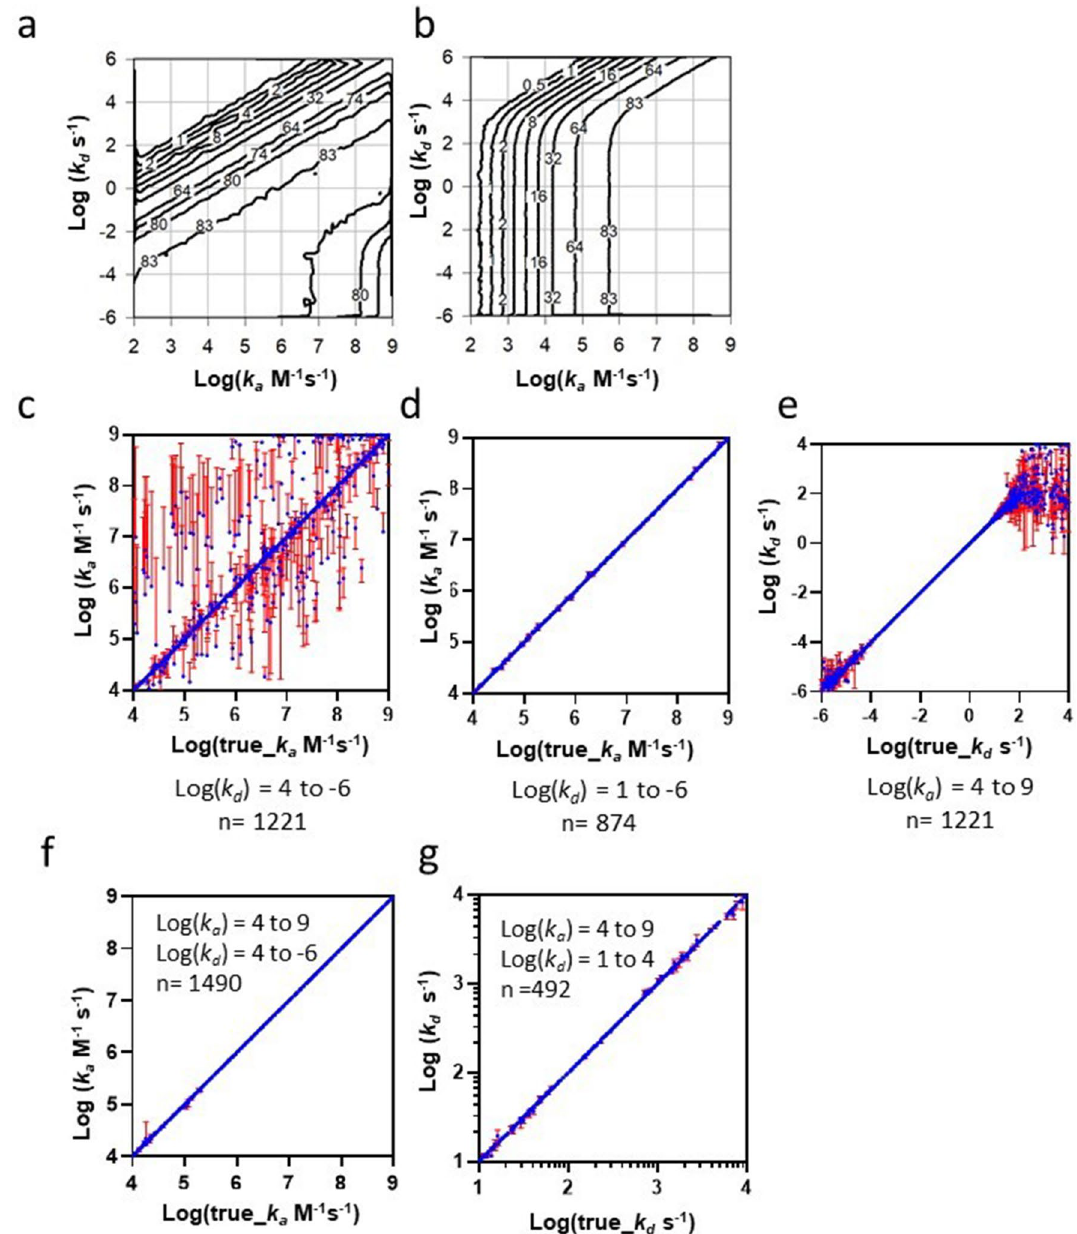
Figure 6. Comparison of the competitive kinetics assay with the rebinding assay in terms of sensitivity and parameter estimation, evaluated using Monte Carlo simulations seeded with pairs of pseudo-random kinetic values. ( a ) Affinity space plot for competitive kinetics with contour curves connecting regions of equal response (response (RU) is inset on contour curves). ( b ) As in ( a ) but replicated for the rebinding assay format. ( c ) Correlation of true_k a versus k a returned from fitting the competitive kinetic model, associated with the parent Monte Carlo simulation, for pseudo-random k a / k d combinations spanning 10-orders with limits 4 ≤ Log( k a ) ≤ 9 and − -6 ≤ Log( k d ) ≤ 4. The diagonal, or unit slope, indicates the accuracy of parameter return and the SE associated with the parameter fit is indicated by the ± error bars. ( d ) Data set given in ( c ) were k a /k d combinations containing transient k d values were eliminated by restricting the k d limit to − -6 ≤ Log( k d ) ≤ 1. ( e ) As in ( d ) but given in terms of the fitted k d versus the true- k d . ( f ) Correlation of fitted k a versus the true_k a for the rebinding assay format. Assay parameters for the Monte Carlo simulations were matched with competitive kinetics in ( c ) and are shown over the full kinetic range given by limits 4 ≤ Log( k a ) ≤ 9 and − 6 ≤ Log( k d ) ≤ 4. ( g ) Correlation of fitted k d versus the true_k d for the rebinding assay in ( f ), where k d was restricted to transient k d values over the limit 1 ≤ Log( k d ) ≤ 4. See methods section for more